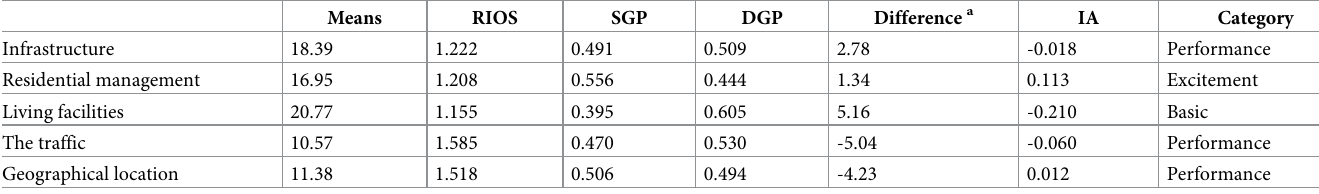
Table 7. Attributes’ performance means and asymmetric impact